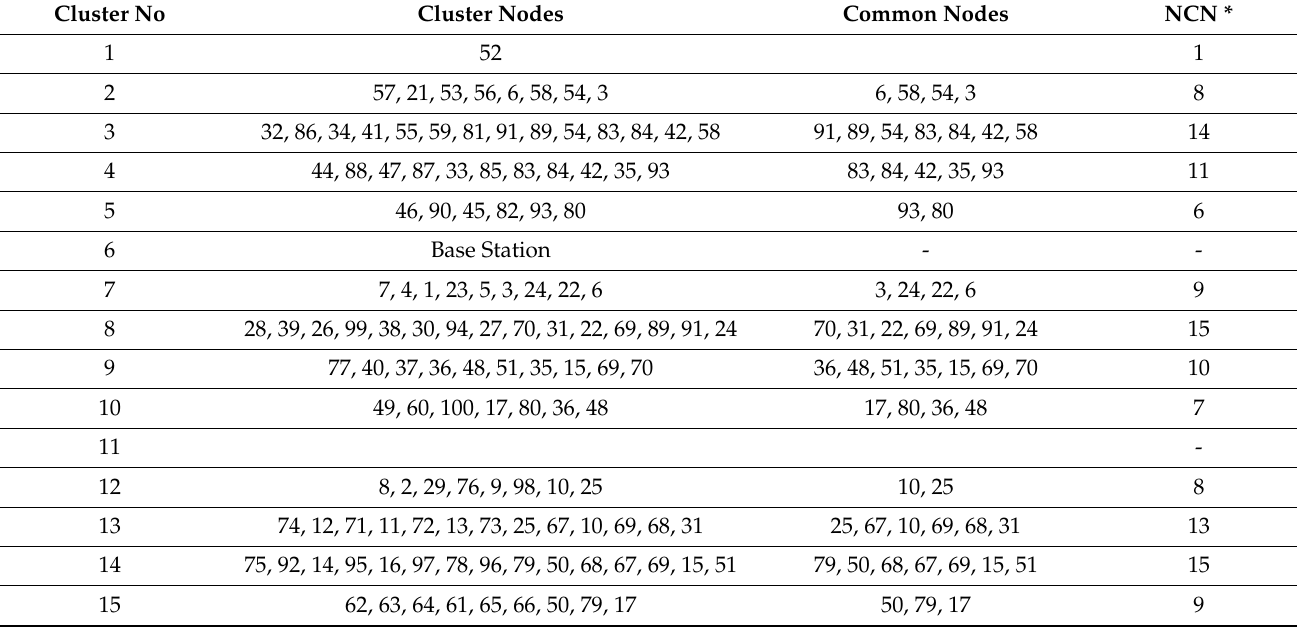
Table 1. The initial state of the